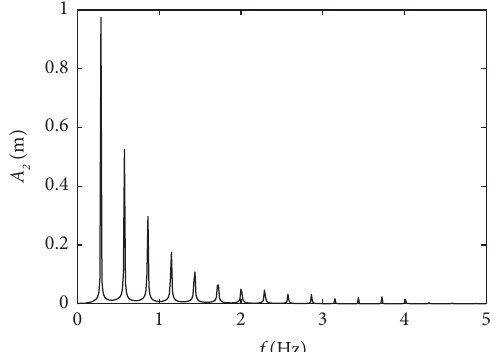
Figure 12: Amplitude frequency curve of normal motion at 10m from anchor